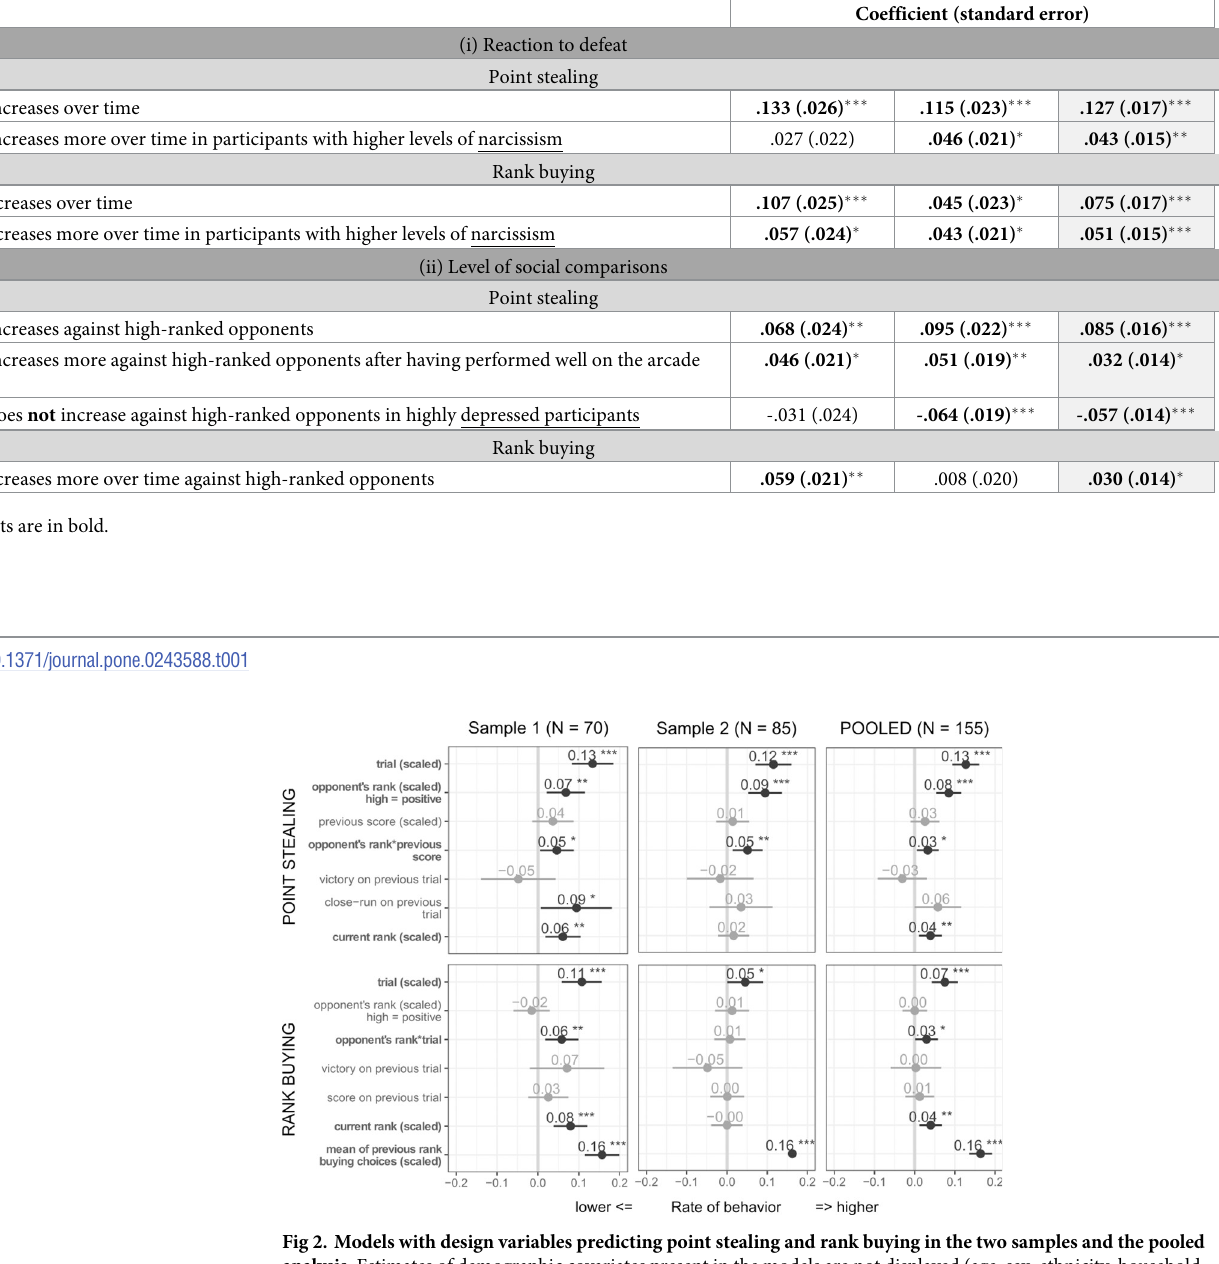
Table 1. Summary of main findings in the two samples and in the pooled analysis encompassing both. Effects significant in the pooled analysis